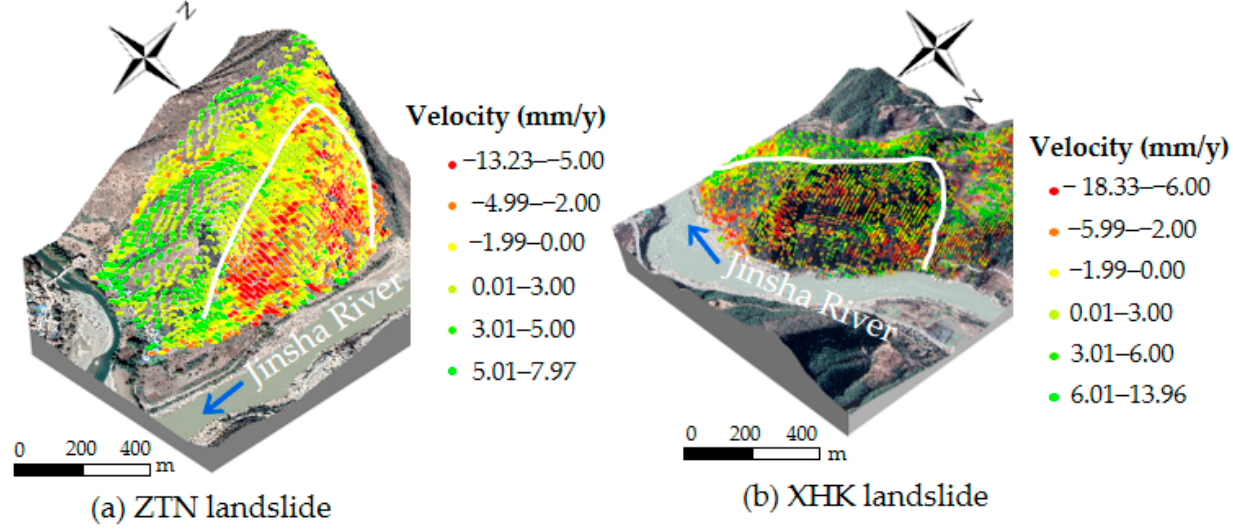
Figure 7. Deformation features of potential landslides with ALOS-2 data.